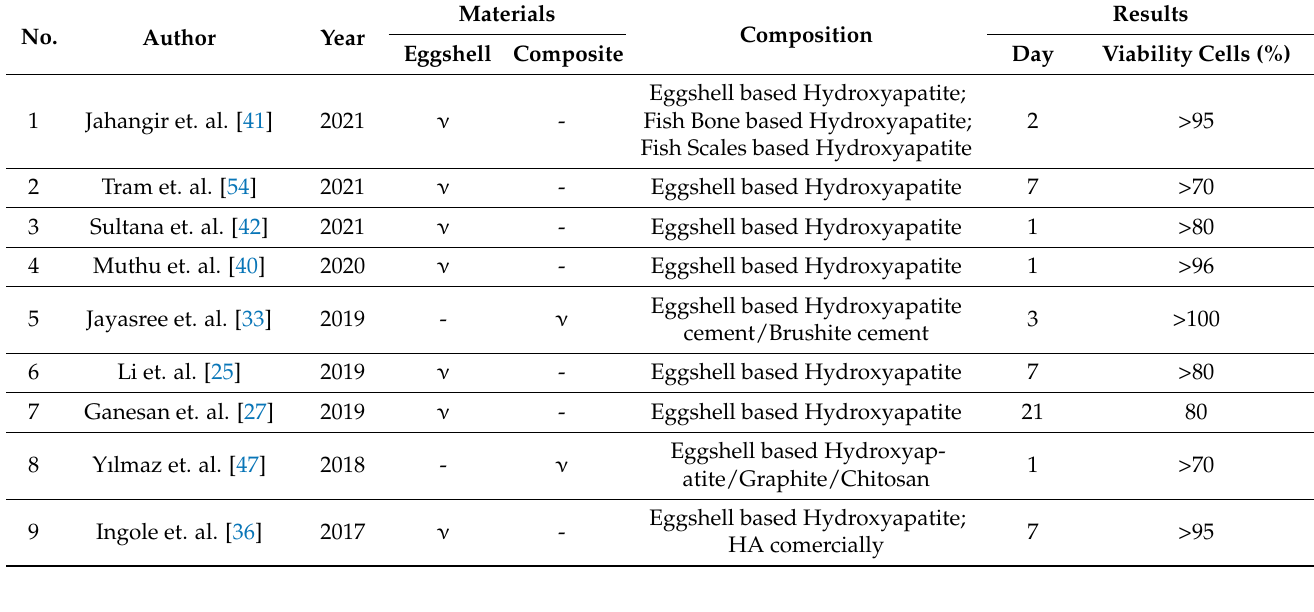
Table 4. Results for viable cell of cytotoxicity testing using stem cells from animals.